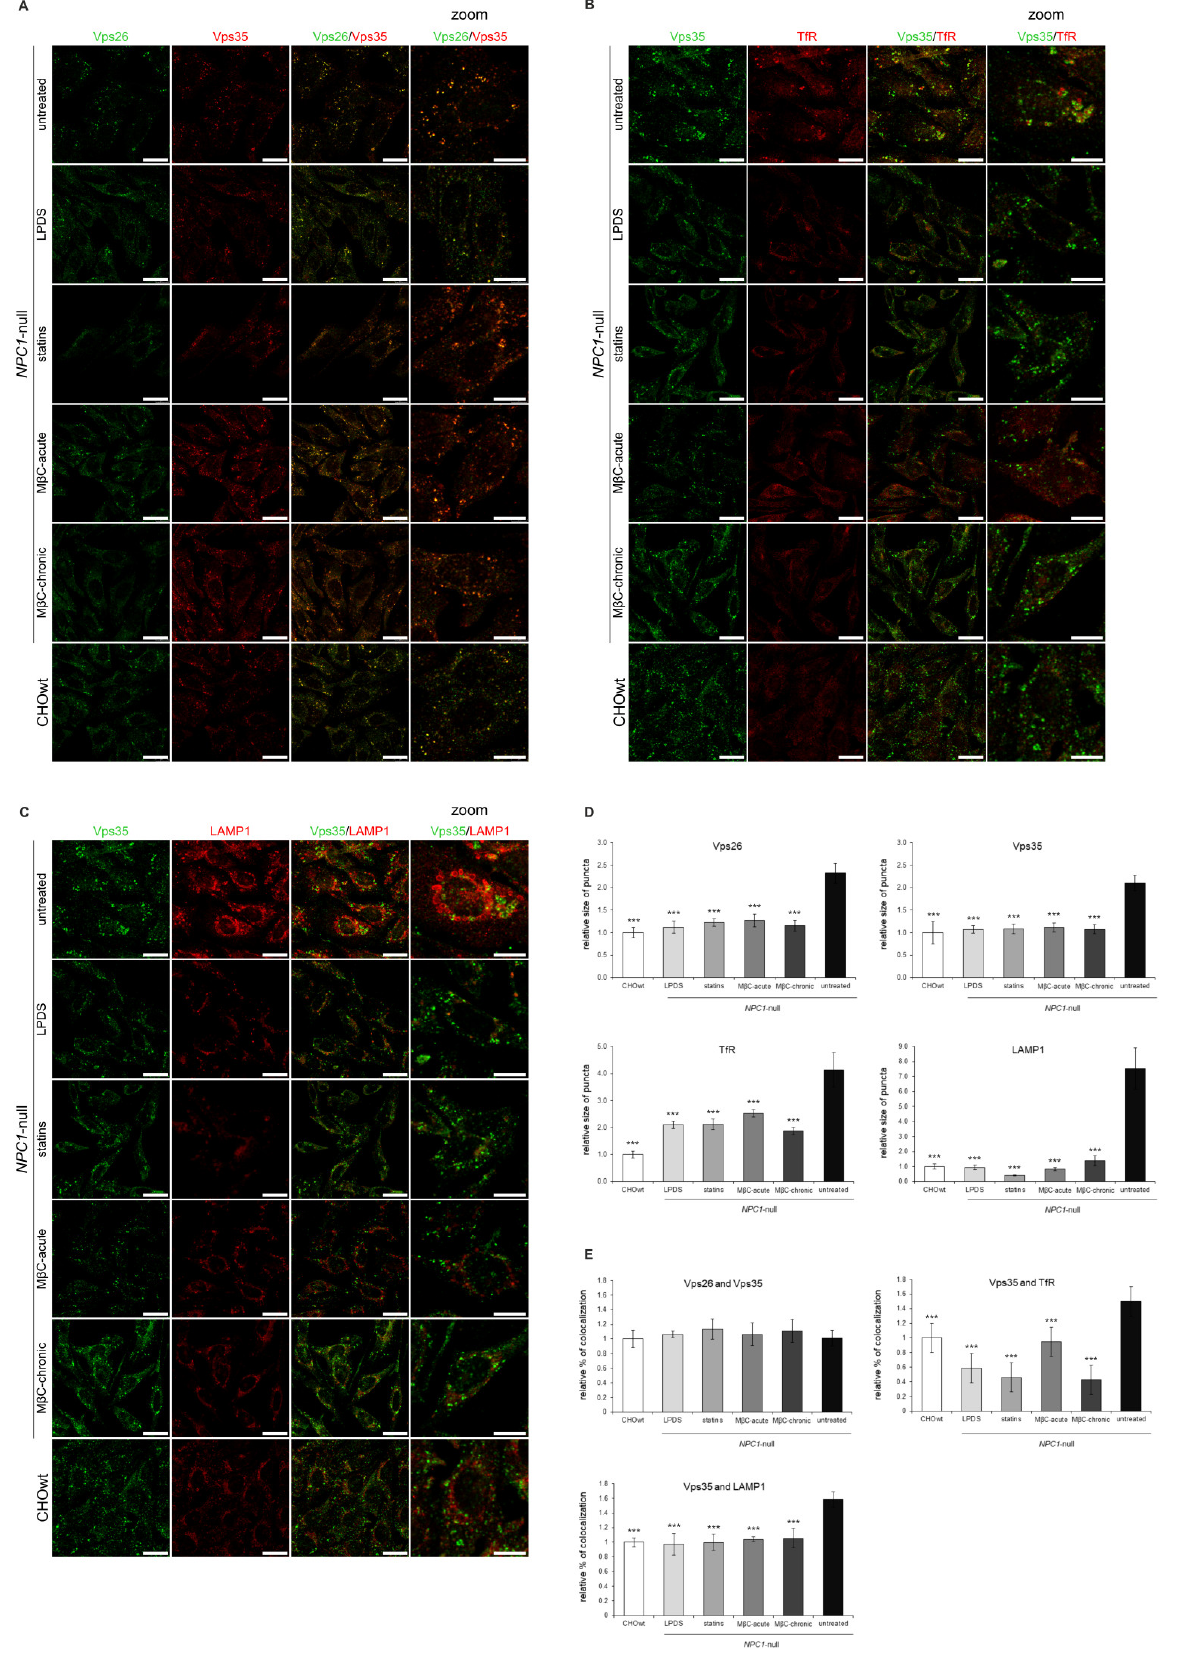
Figure 8. Retromer and endolysosomal trafficking defect is rescued upon cholesterol depletion in vitro in NPC1 -null